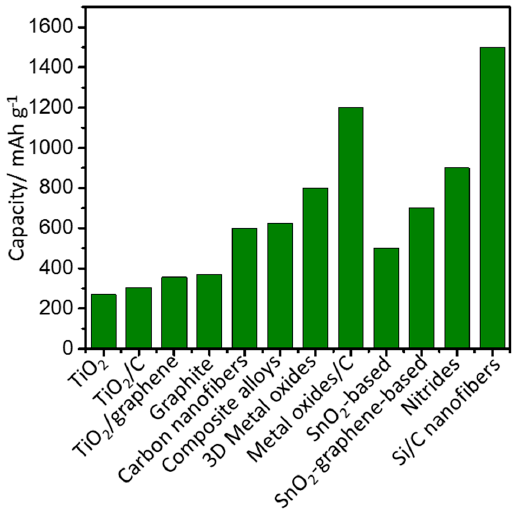
Figure 1. Comparison of the reversible capacity of some anode materials for lithium ion batteries.